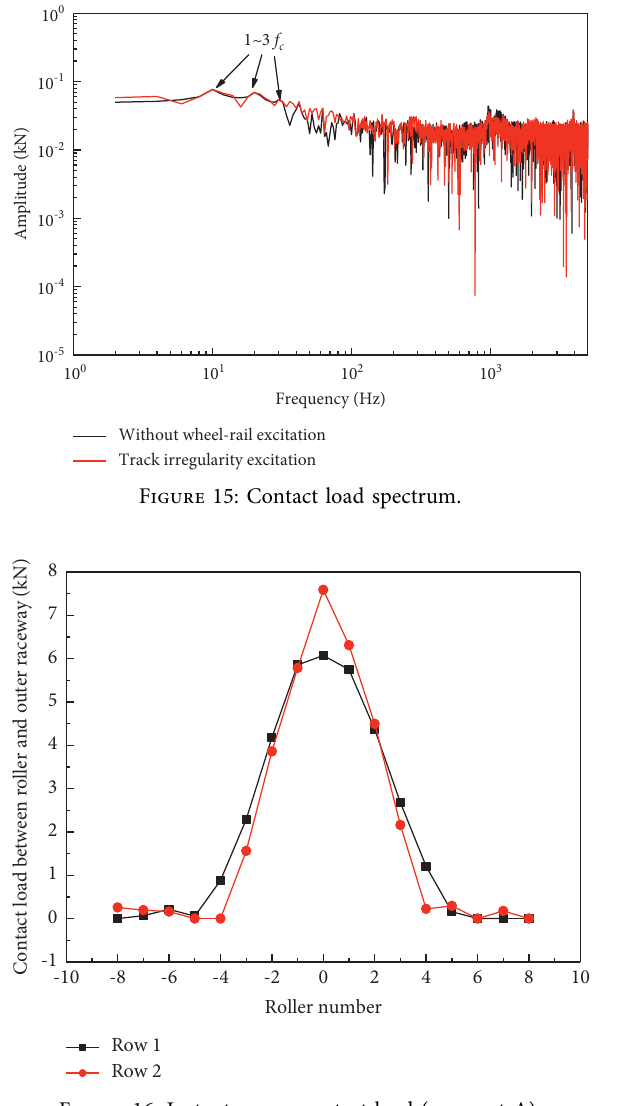
Figure 16: Instantaneous contact load (moment A).